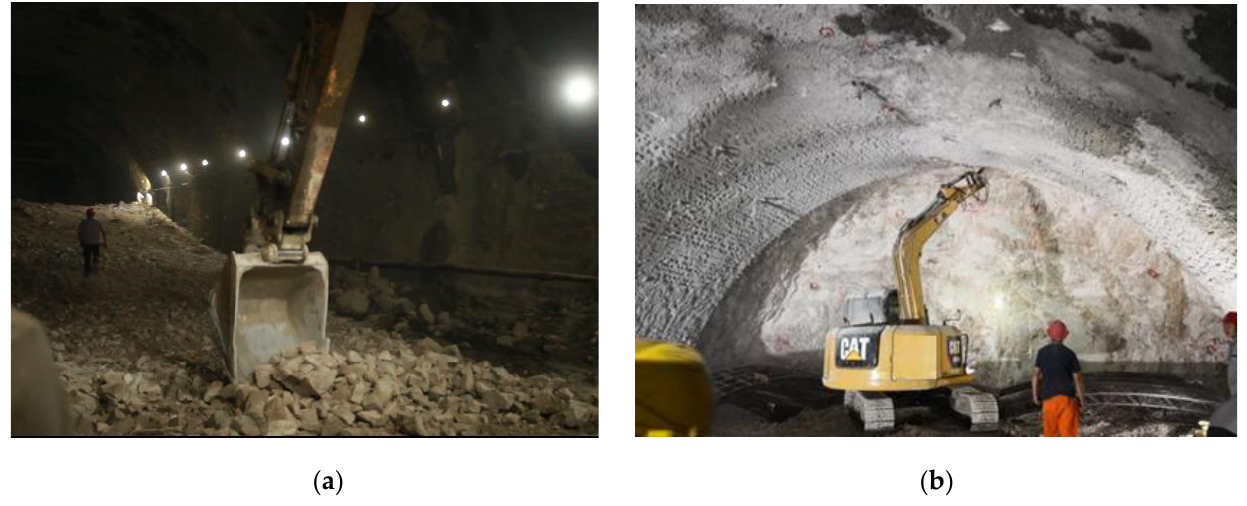
Figure 24. The preparation before construction. ( a ) Road surface treatment and ( b ) the overbreak and underbreak treatment.